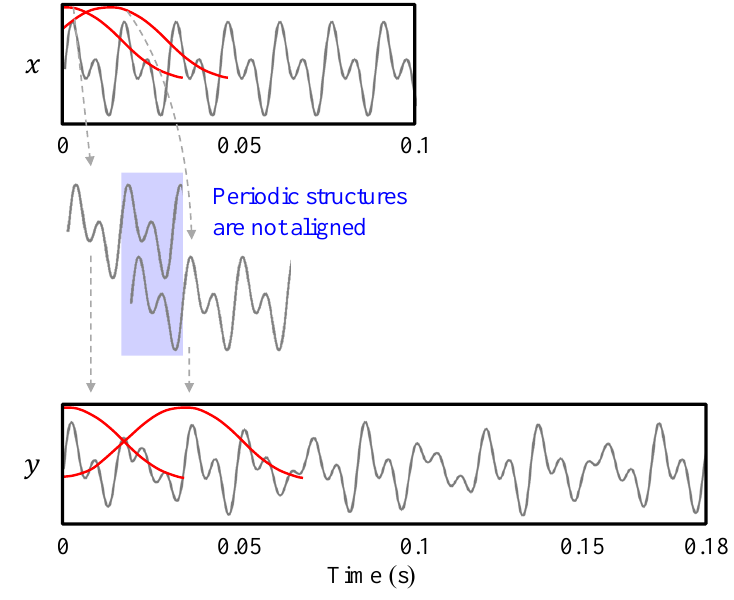
Figure 4. Illustration of a typical artifact for an audio signal modified with OLA. In this example, the input signal x is stretched by a factor of α = 1.8. The OLA procedure is visualized for two frames indicated by window functions. The periodic structure of x is not preserved in the output signal y